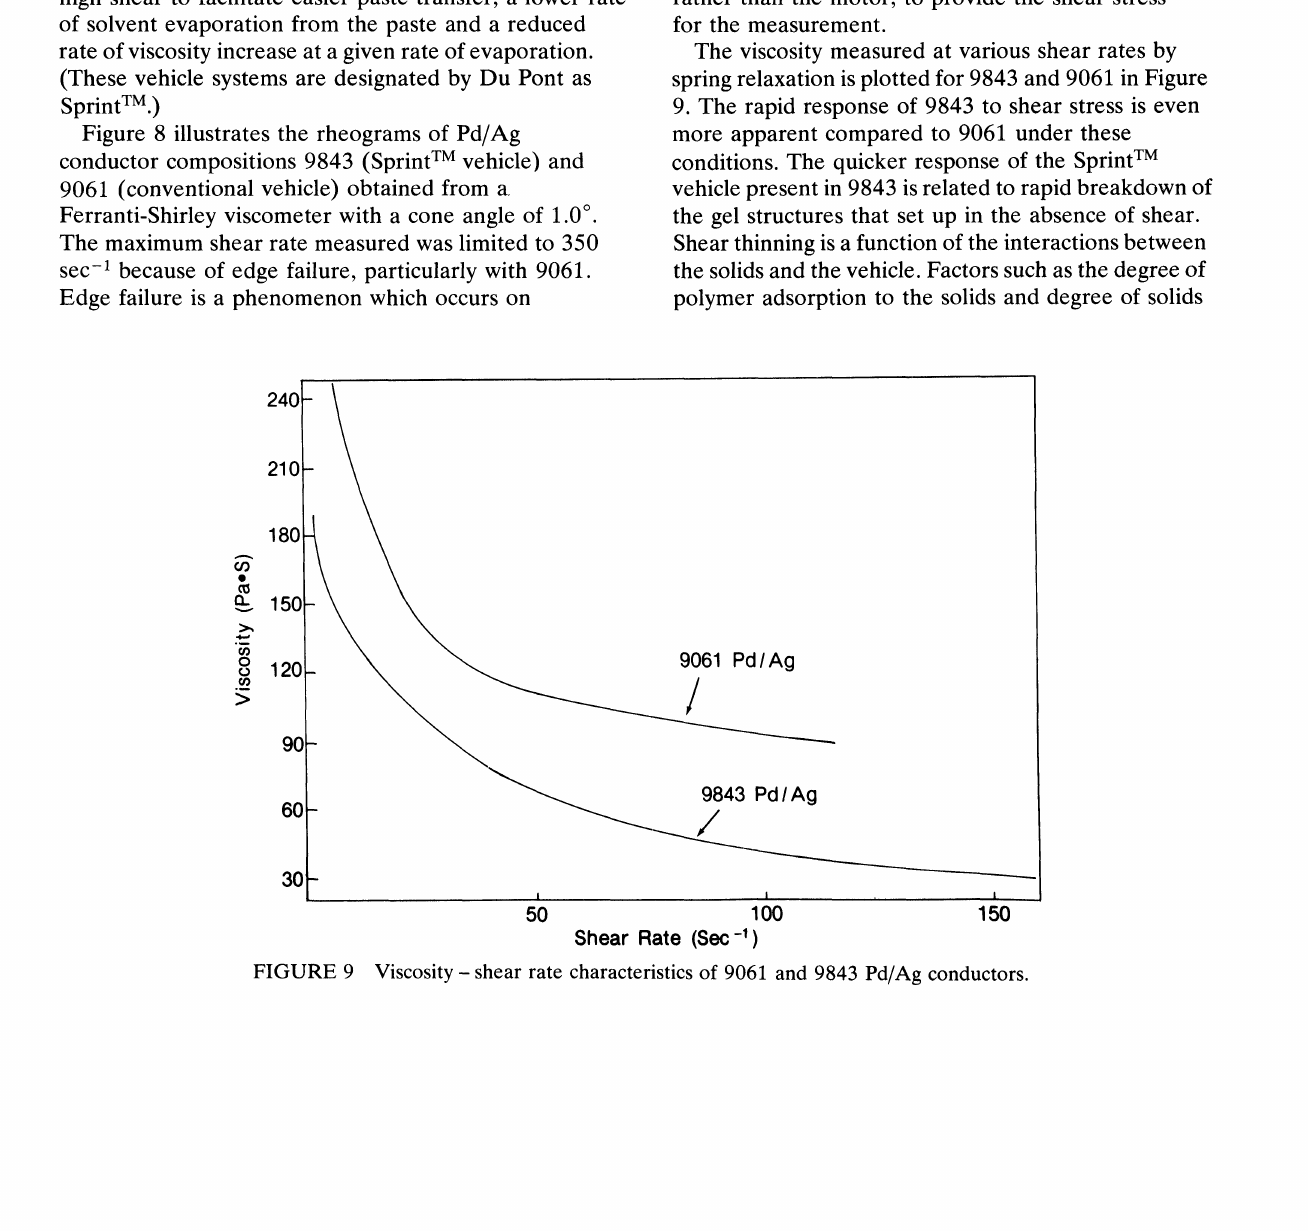
FIGURE 8 Shear rate vs. shear stress for 9061 and 9843 Pd/Ag conductors.